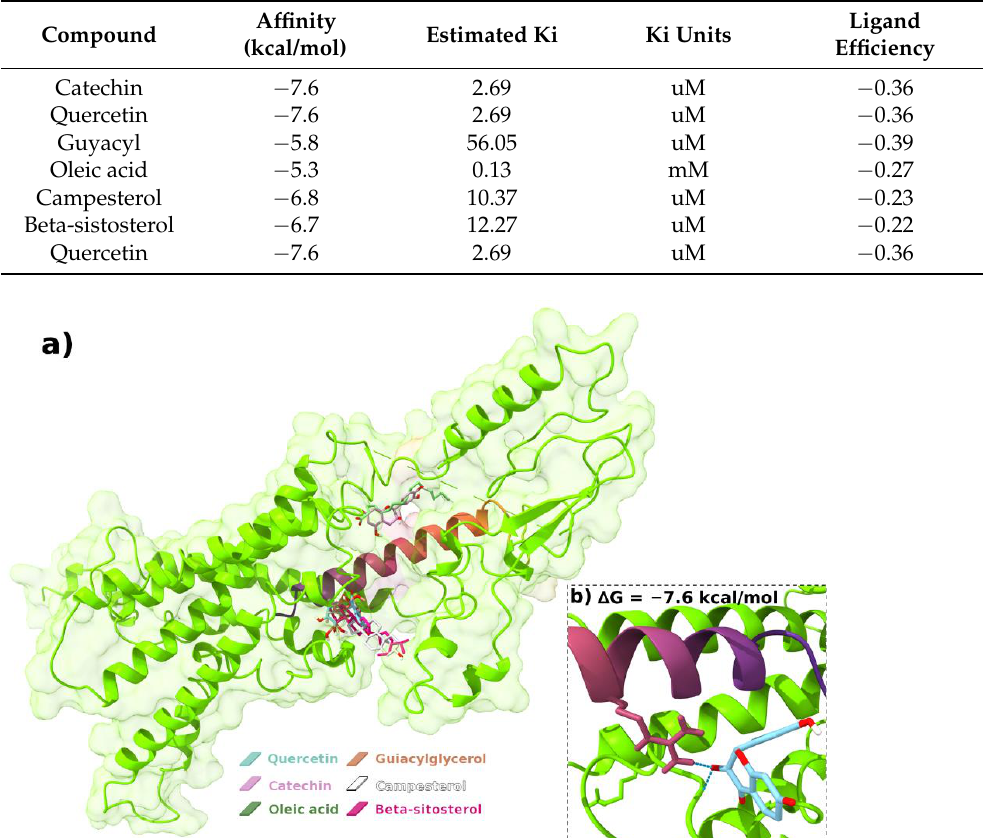
Table 2. Molecular docking for all investigated compounds has two forms of interaction with the protein, two binding sites.